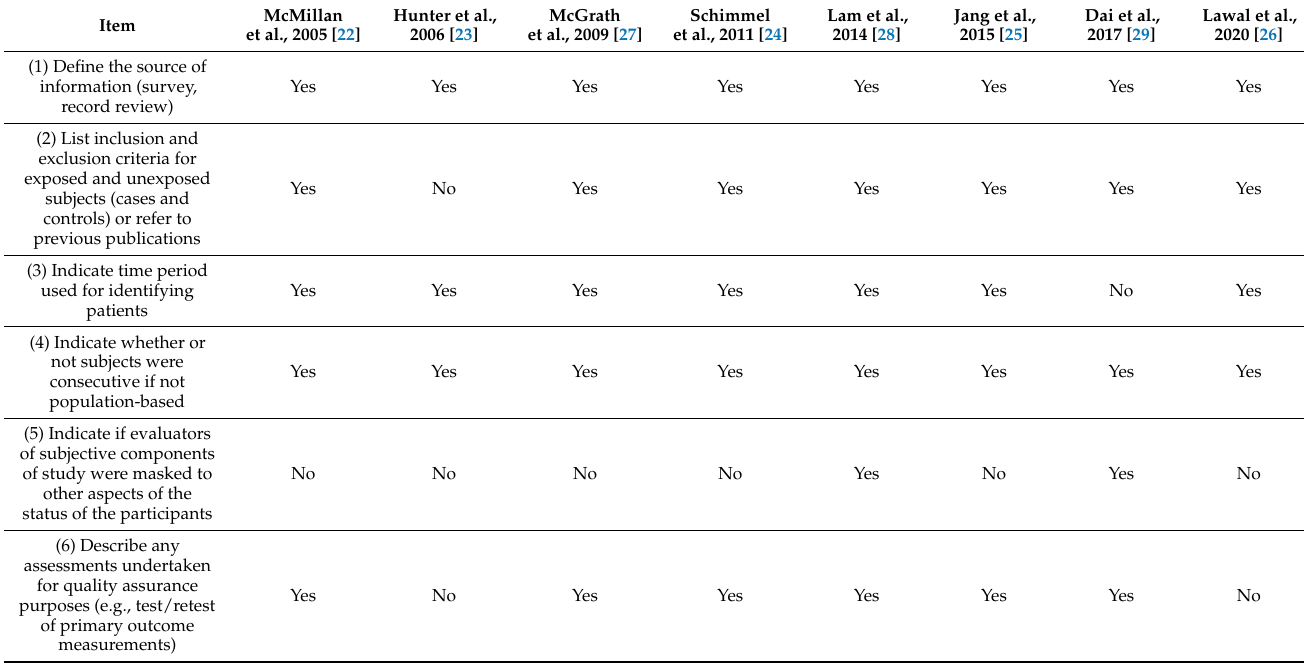
Table 2. Quality appraisal following the Agency for Healthcare Research and Quality (ARHQ)